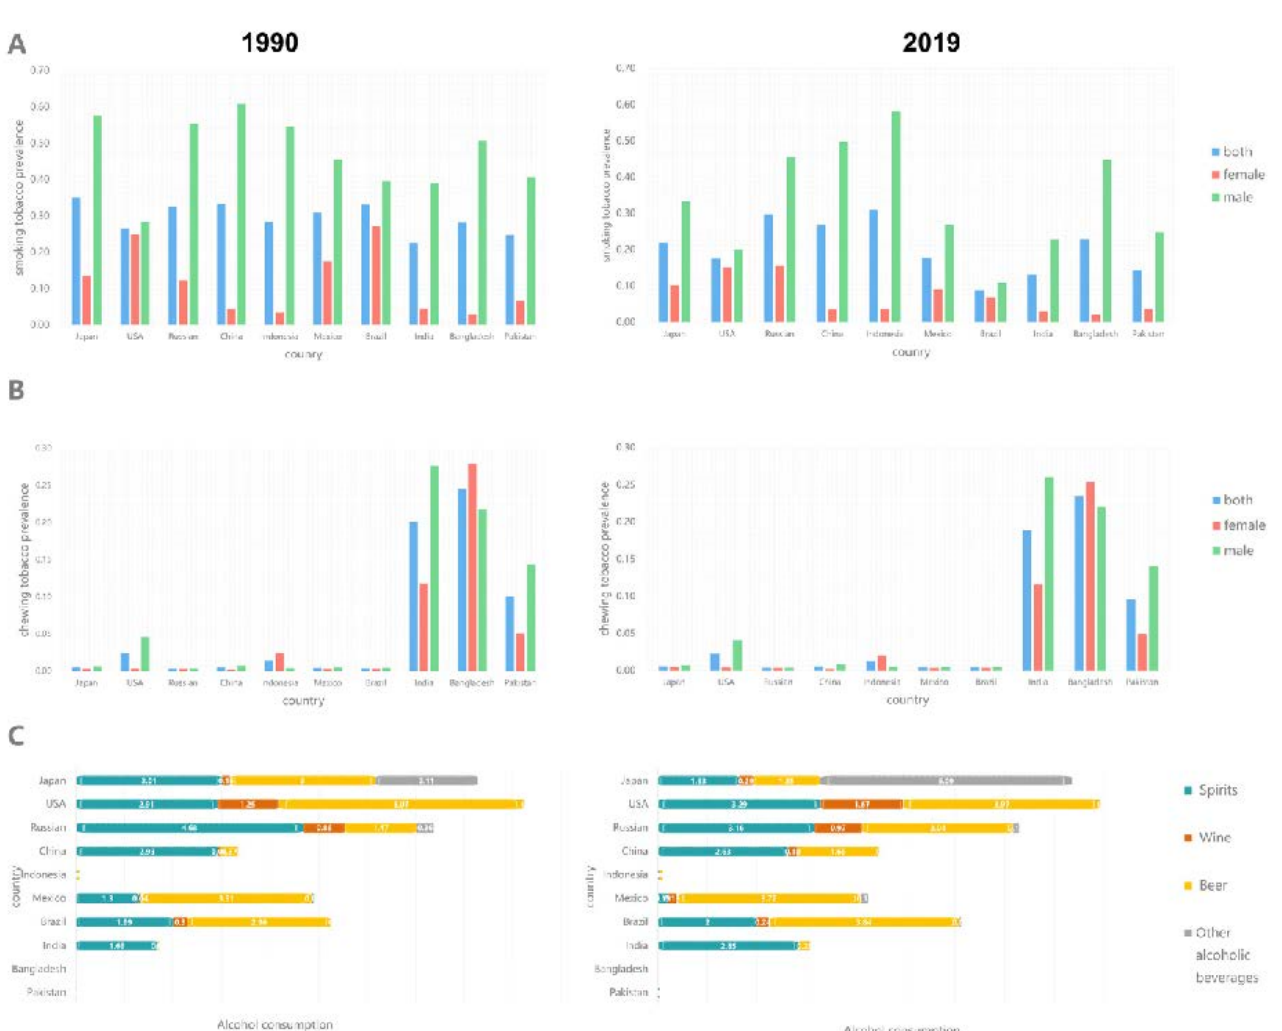
Figure 6. The prevalence of smoking tobacco and chewing tobacco and the consumption of alcohol in ten countries in 1990 and 2019. ( A ) Smoking tobacco prevalence in 1990 and 2019; ( B ) Chewing tobacco prevalence in 1990 and 2019; ( C ) Alcohol, recorded per capita (15+) consumption (in litres of pure alcohol) in 1990 and